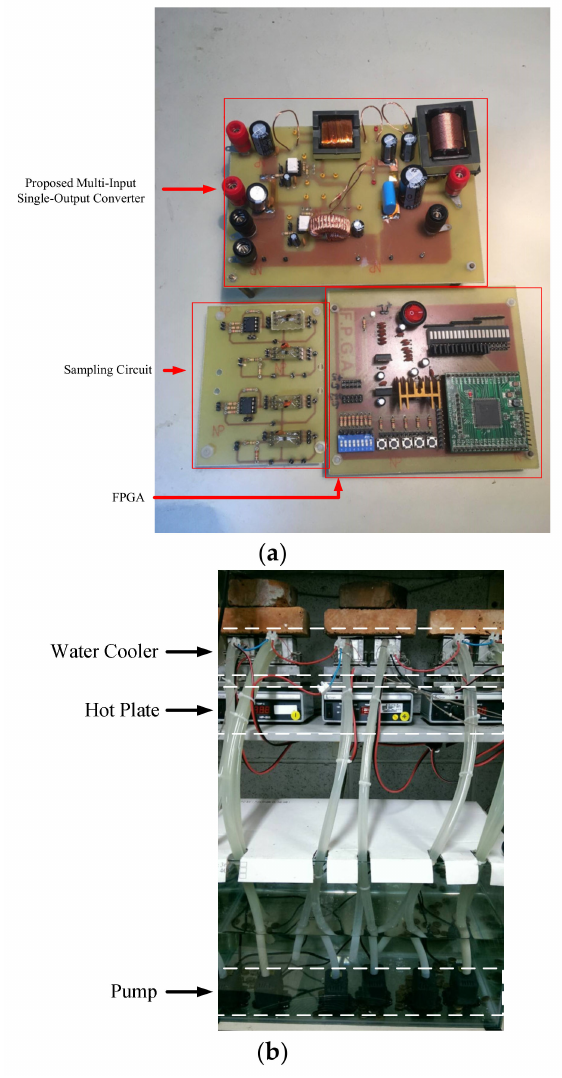
Figure 27. Photos of the proposed thermoelectric system: ( a ) MISOC circuit; ( b ) thermoelectric plat-